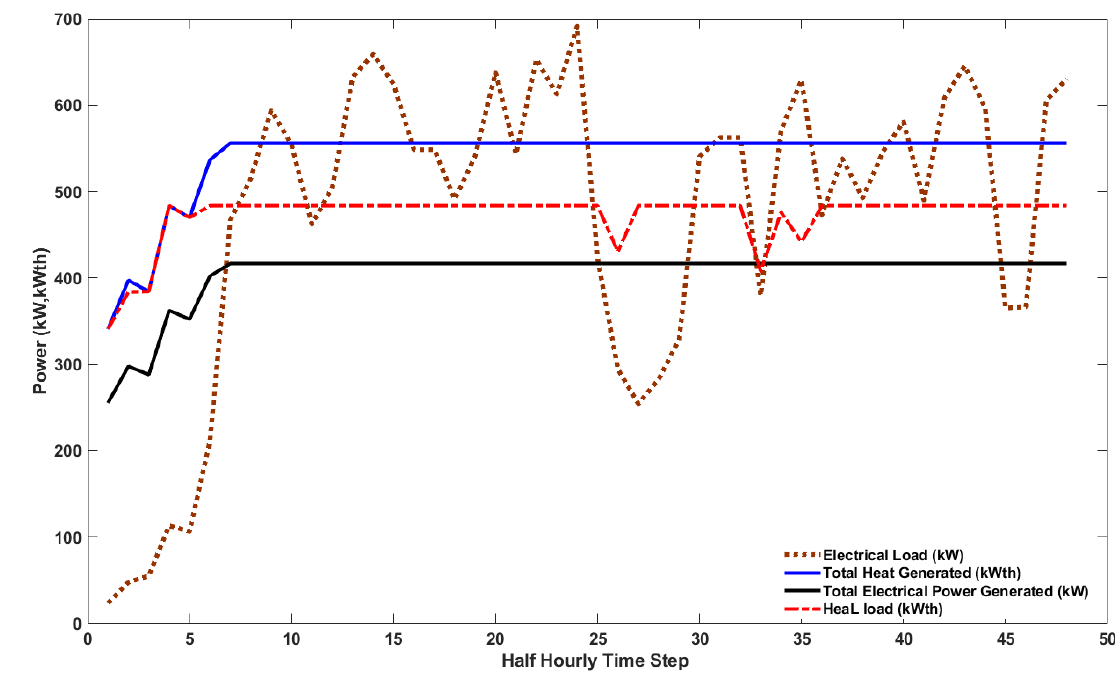
Figure 15. Total power and heat generated from 2×250 kWe CHP units vs. real-time electrical load (online optimisation).